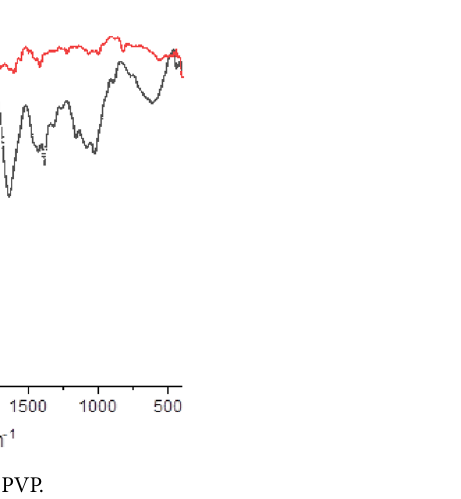
Figure 3. IR spectra of ( a ) Cs and ( b )